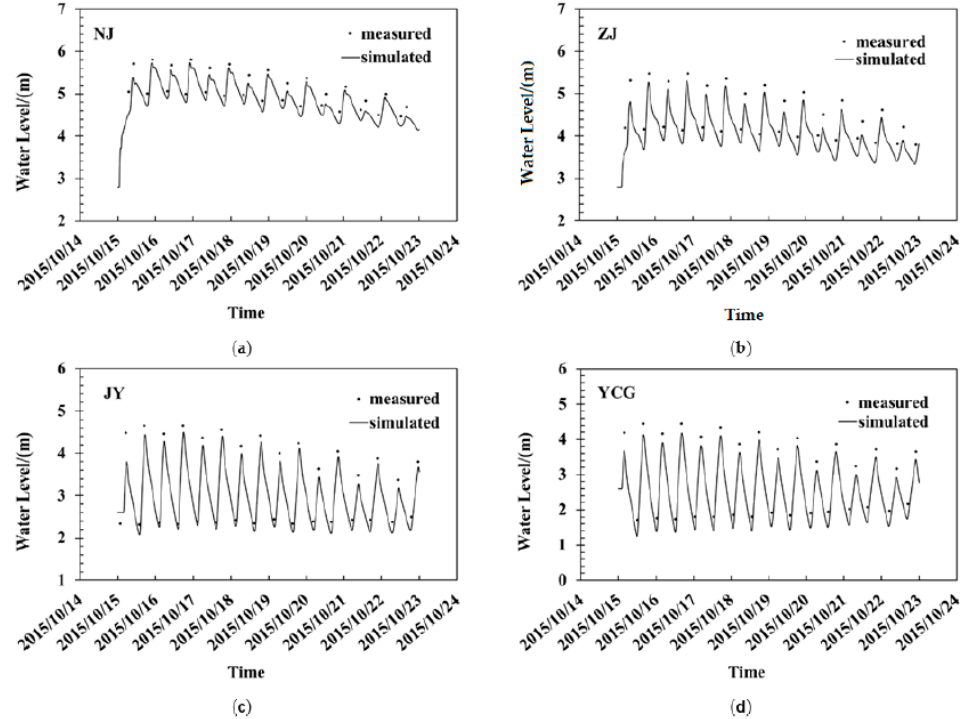
Figure 3. Calibration and validation for water level: ( a ) Nanjing (NJ); ( b ) Zhenjiang (ZJ); ( c ) Jiangyin (JY); ( d ) Yingchuangang